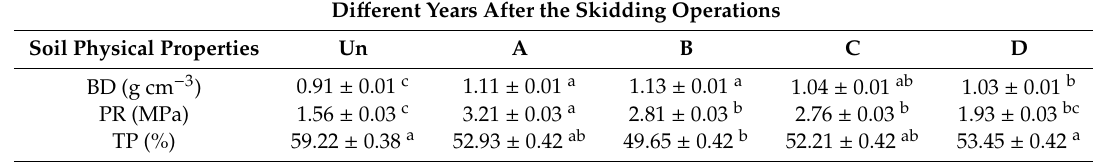
Table 8. Changes in soil bulk density, penetration resistance and total porosity (mean ± standard error) in di ff erent years after the skidding operations. A, B, C, D, and Un represent, respectively, skid trails after a period of 5 years, 10 years, 15 years, 20 years and Undisturbed area. Di ff erent Years After the Skidding Operations